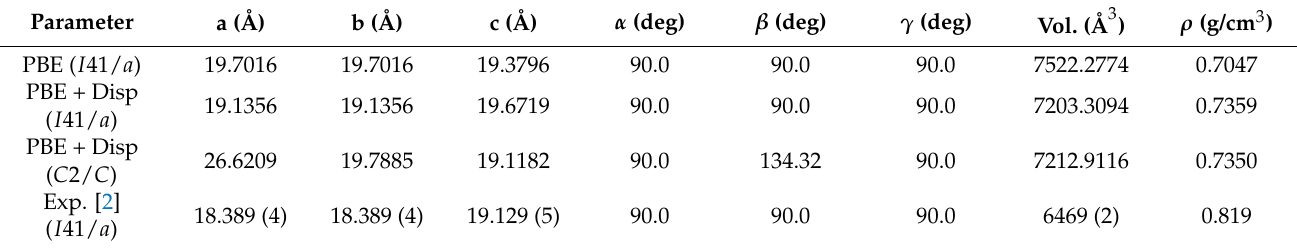
Table 1. Computed unit cell parameters of